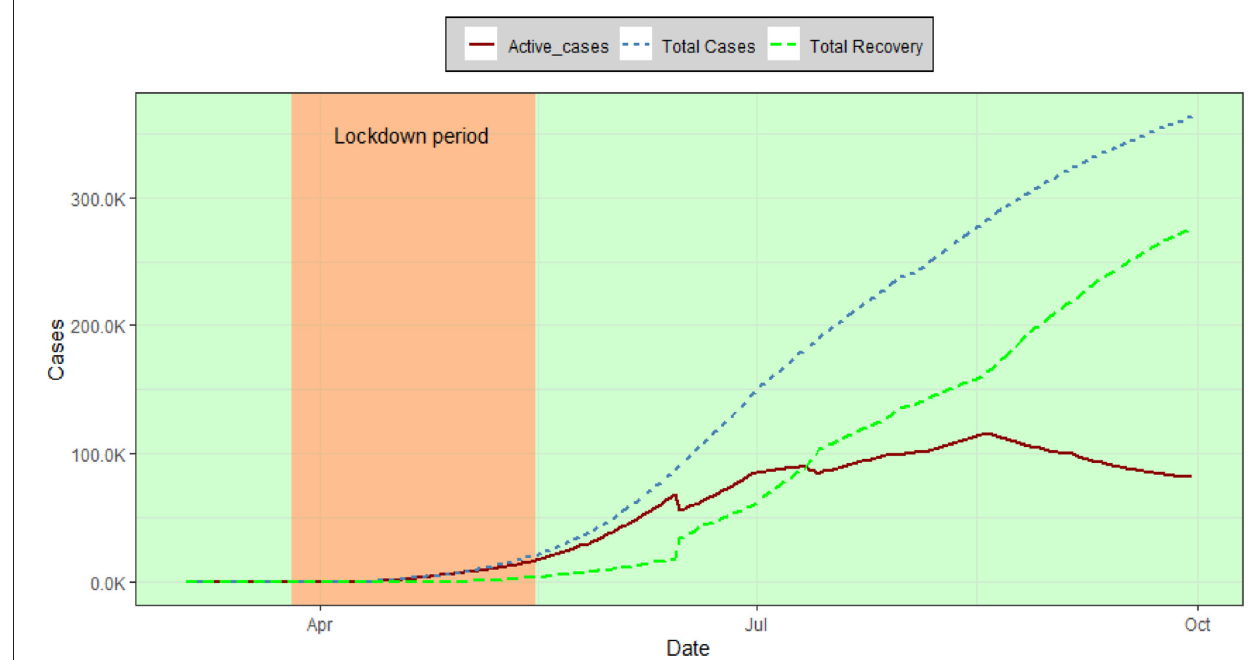
FIGURE 2 | Total cases, recovery, and active cases over time in Bangladesh.